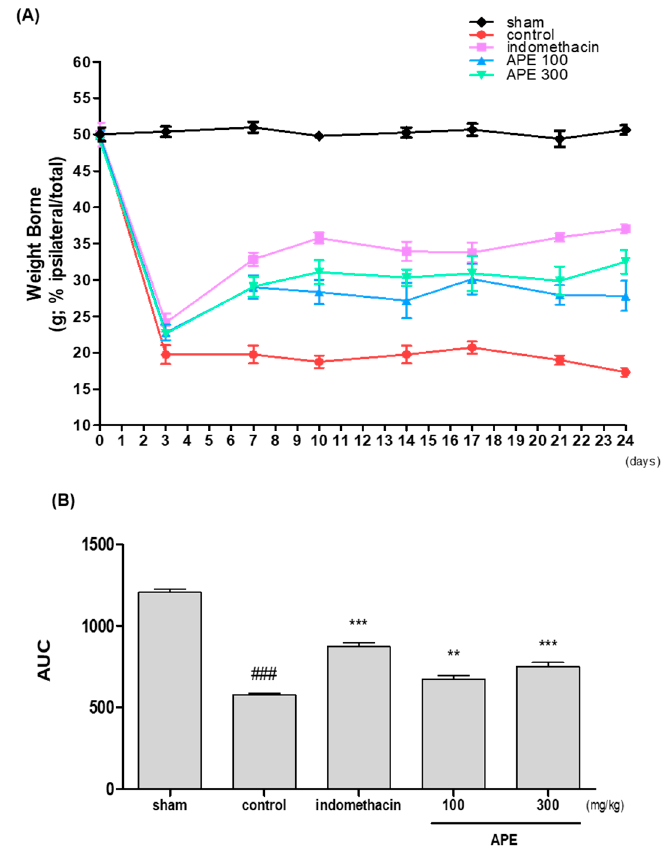
Figure 2. The effects of Andrographis paniculata extract on weight-bearing of hind paw in the iodoacetate (MIA)-induced osteoarthritis model. ( A ) Weight-bearing distribution of MIA rats on 0, 3, 7, 10, 14, 17, 21, 24 days with 100 and 300 mg / kg Andrographis paniculata extract or 3 mg / kg indomethacin treatment and ( B ) area under the curve (AUC) were recorded using incapacitance meter tester. ### p < 0.001 vs. sham, ** p < 0.01 vs. control *** p < 0.001 vs.